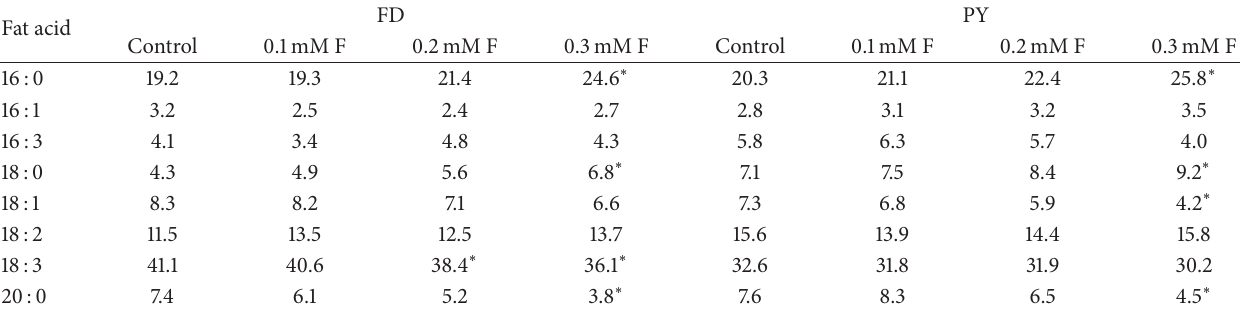
Table 1: Fatty acid composition in leaves of PY and FD after 2 weeks of fluoride (F) treatments. Contents are given as percentage of total fatty acid weight. Data are the mean of four replicates. Minor fatty acids less than 1% of the total amount are not shown. Fatty acids are abbreviated as the number of carbon atoms followed by the number of double bonds in the fatty acid.